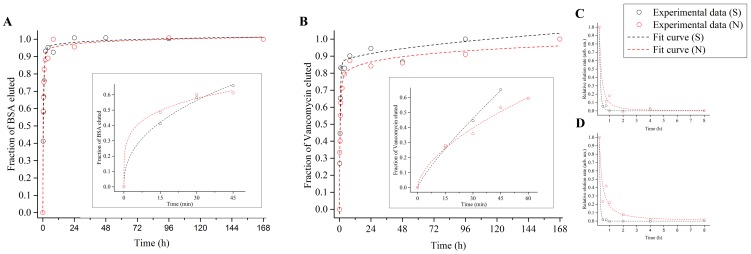
Representative examples of the fitting process.(A) Elution of BSA fitted with equation (1) and calculation of the elution exponential n (inset); (B) elution of vancomycin fitted with equation (1) and calculation of the elution exponential n (inset). (C) Relative elution rate of BSA fitted with equation (2); (D) relative elution rate of vancomycin fitted with equation (2).